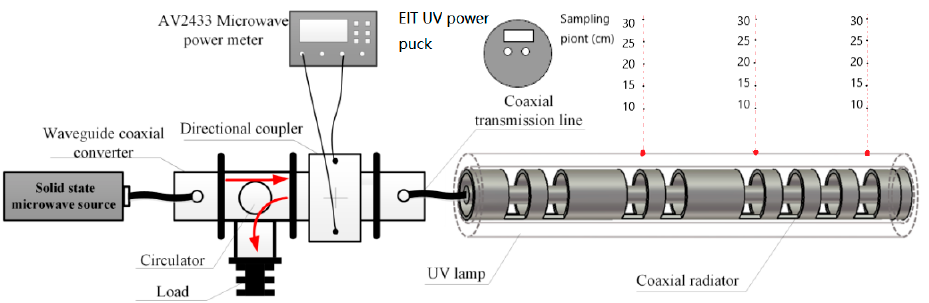
Figure 12. Comparison of S11 with different plasma collision frequencies.